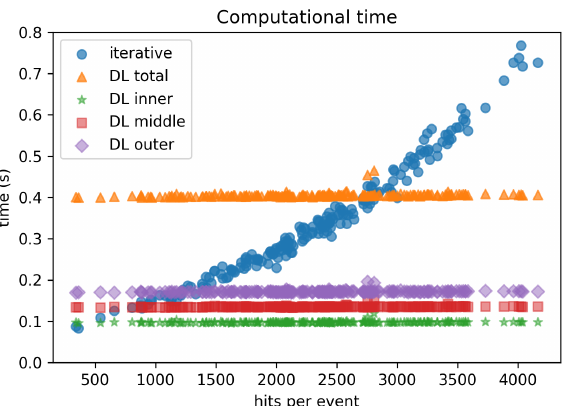
Figure 6. Scatter plot of the mean computational time over the number of readout cells per event from LHCb simulations. Comparing the Python version of the LHCb algorithm (iterative) and the proposed deep learning implementation (DL total) with executions segmented by regions (DL inner, DL middle, DL outer). Hits refer to the readout cells with energy on a